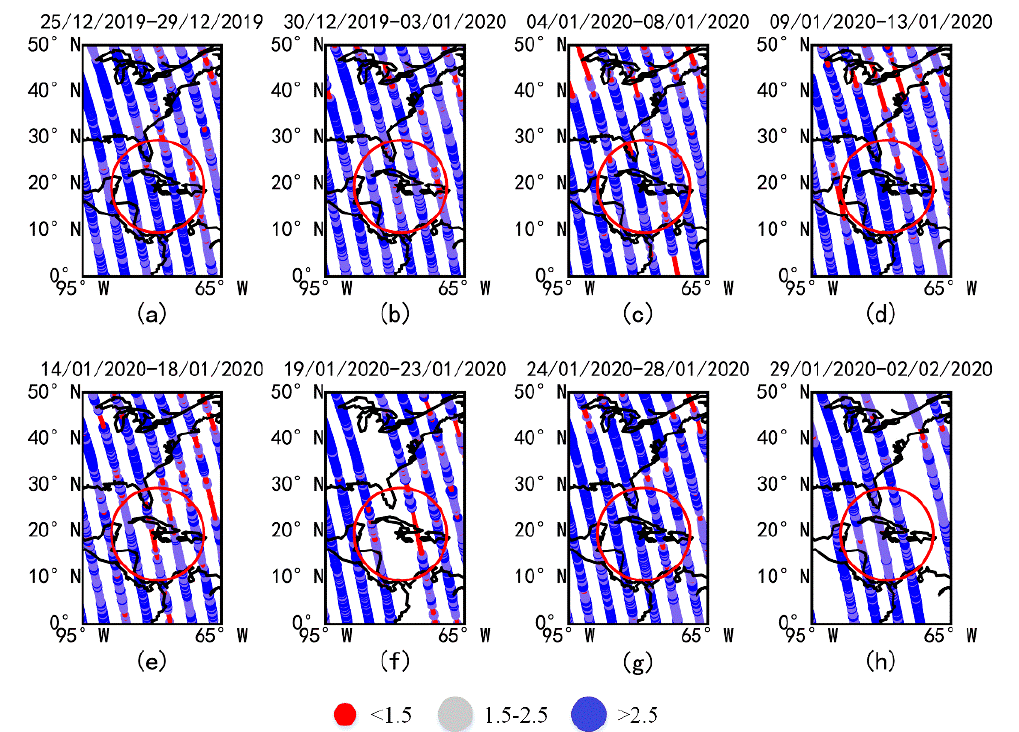
Figure 4. The space–time diagram of the electric field signal-to-noise ratio over the NLK transmitting station observed by the ZH-1 satellite (The eight subplots ( a – h ) represent a total of eight cycles from 25 December 2019, while the satellite operated every five days to 2 February 2020. The black star indicates the location of the epicenter, and the red circles indicate the seismogenic zone).